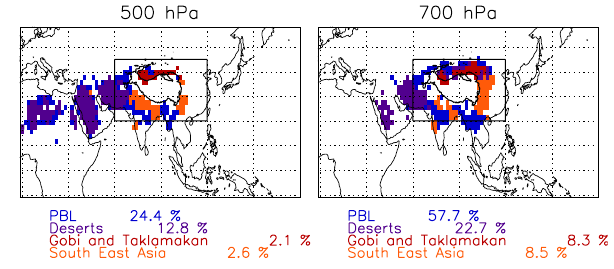
Fig. 7. Geographical distribution of PBL exit points for back tra- jectories at 500hPa (left) and 700hPa (right). Different sources are plotted with the color table reported in the figure together with its relative contribution. Black box indicates the starting point area of the back trajectories. Analysis includes the 2007–2010 spring sea-